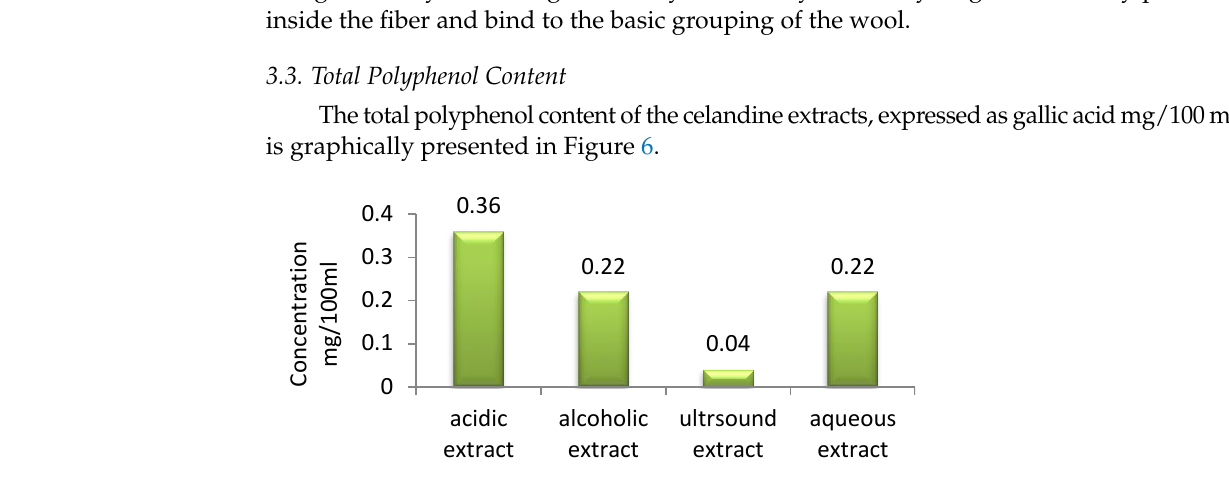
Figure 6. Total polyphenol content.